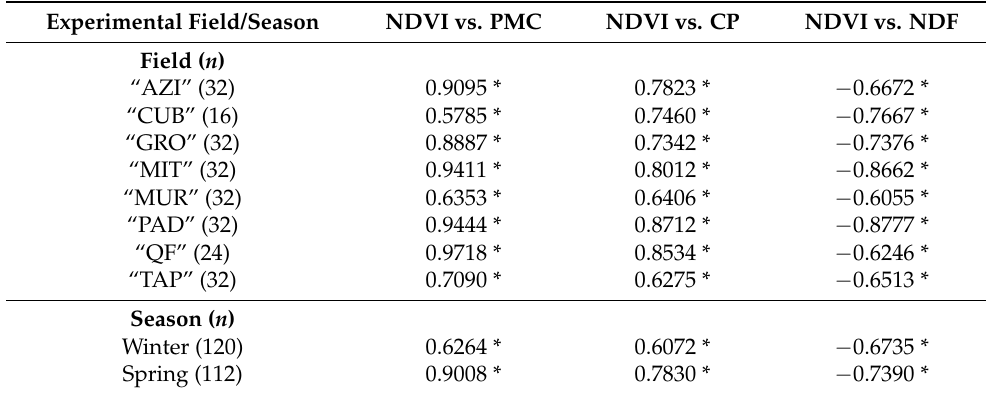
Table 4. Linear correlation coefficients (r) obtained in each field and season between NDVI, measured by active optical sensor in each sampling point and four dates (three in “QF” and two in “CUB”), and the correspondent reference values of pasture moisture content (PMC), crude protein (CP) and neutral detergent fiber (NDF).